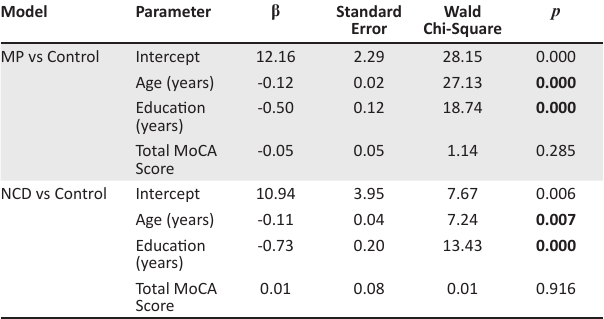
FIGURE 1: The effect of years of education on total Montreal Cognitive Assessment TABLE 5: Regression analysis of parameters for each clinical group versus controls.